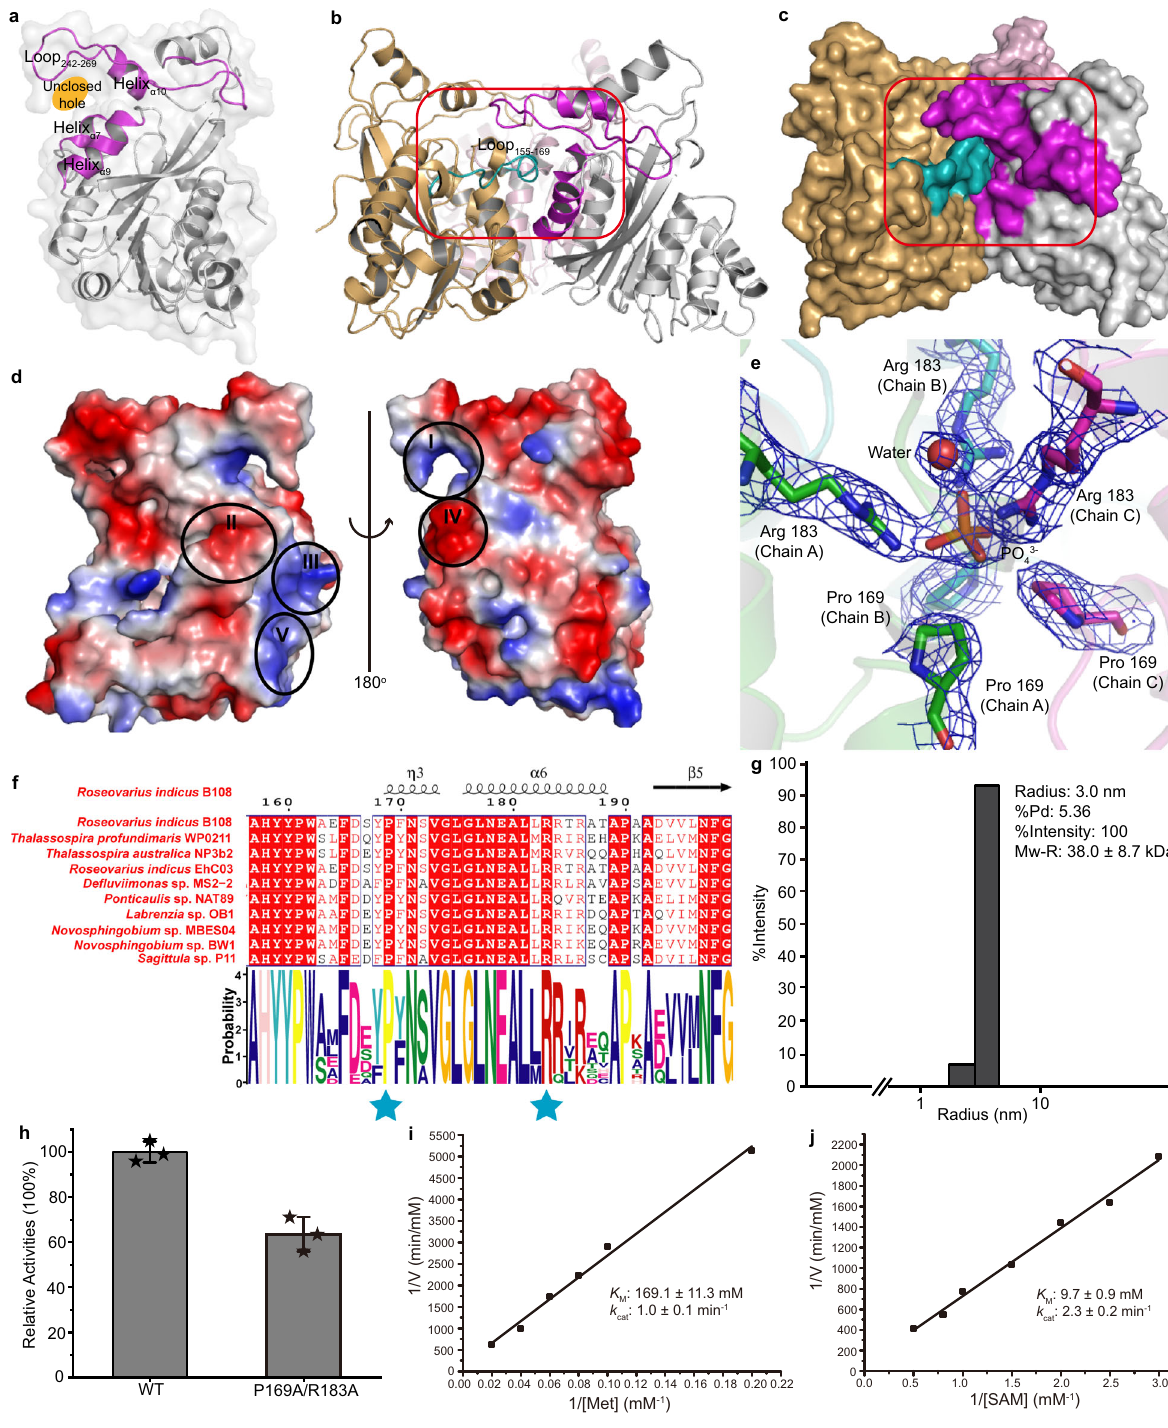
(Fig. 2d). Ion chromatography measurements implied that the ion in MmtN was a phosphate ion (PO 4 3- ) (Supplementary Fig. 3), consistent with the result of PO 4 3- detection analysis using the PiColorLock reagent kit (Expedeon, UK) 41 . Each MmtN monomer, which is composed of six β -strands and eleven α -helices, consists of a cap domain and a Rossmann-like domain 42,43 (Fig. 2f). In the MmtN trimer structure, loop 242 – 269 , helix α 7 , helix α 9 , and helix α 10 of one monomer generate an unclosed hole (Fig. 3a), and loop 159 – 169 of an adjacent MmtN monomer pops out from the